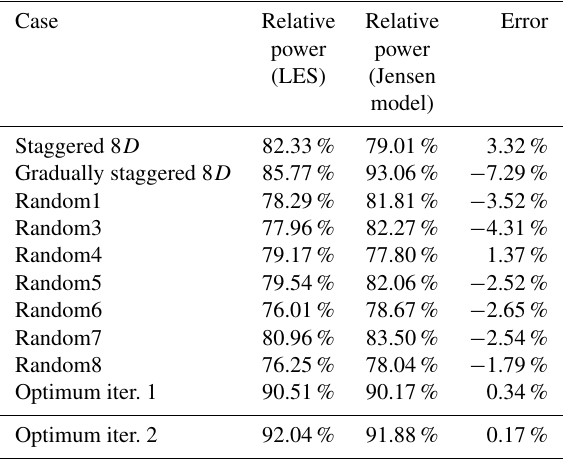
Table 5. Iteration 2: comparing outputs of LES and Jensen wake model with k w = 0.036.